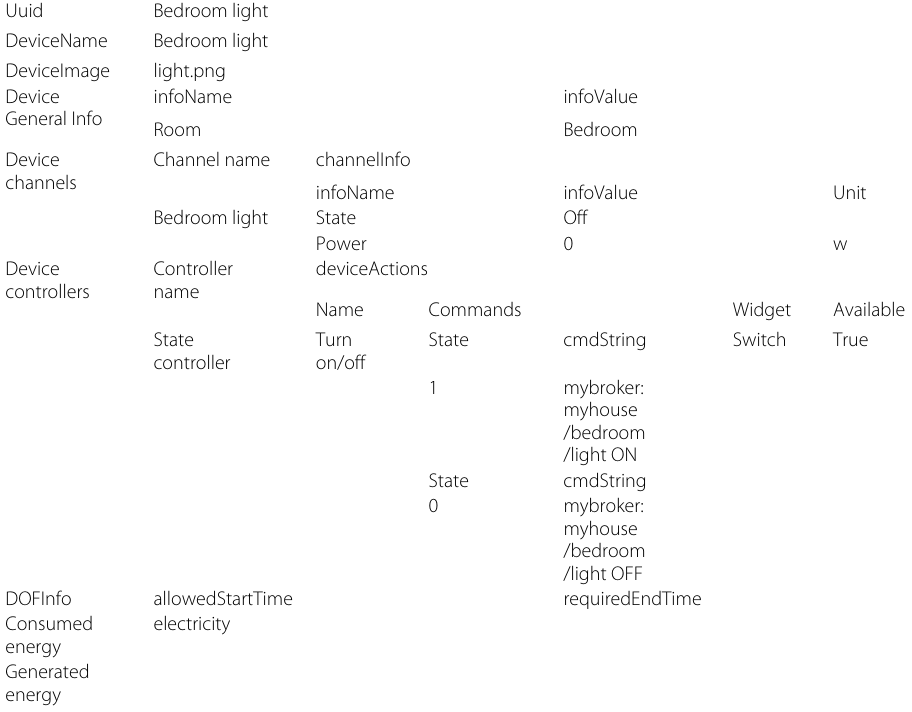
Table 3 The result of converting a switch Item in openHAB into the data model of the BOS UI Uuid